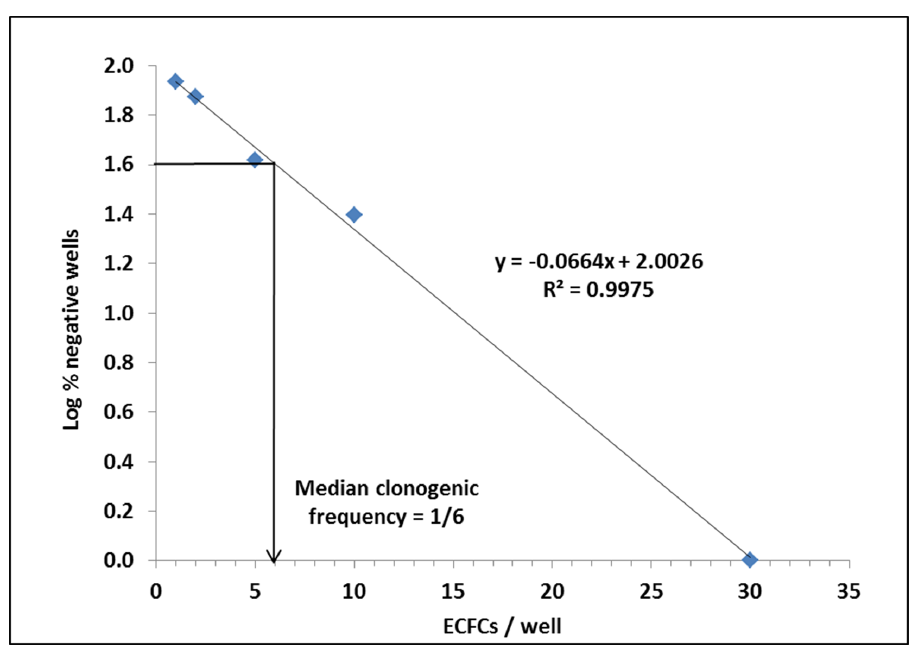
Fig 1. Assessment of human CB-ECFC secondary clonogenicity. Secondary clonogenicity frequency was estimated as 37% log (1.6) intercept.